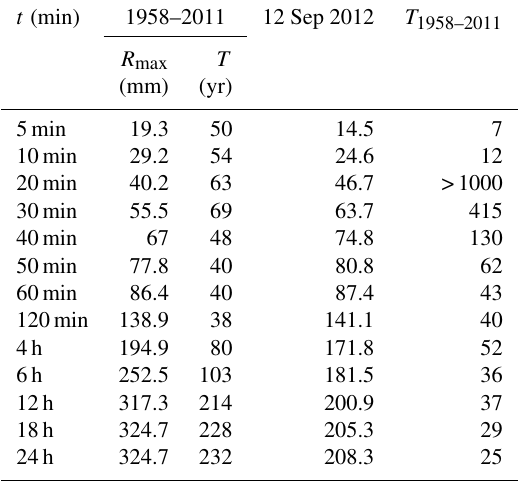
Table 5. Annual maximal precipitation amounts ( R max ) recorded in different intervals t (min) throughout the period 1958–2011 and during the heavy rainfall event on 12 September 2012 at Rijeka and their return values ( T ) according to the GEV distribution applied to the period